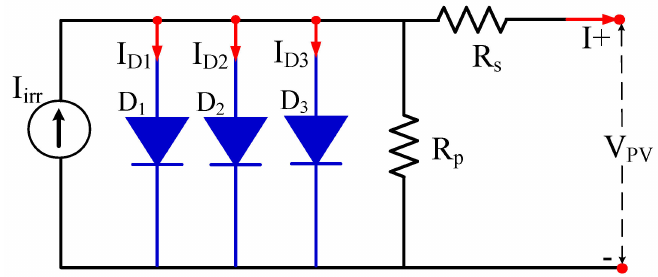
Figure 3. Electrical circuit of